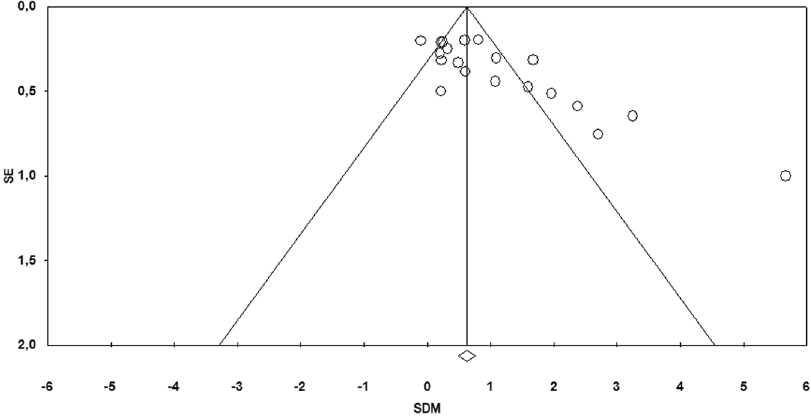
Figure 4. Funnel plot of standard error (SE) by standardised difference in means (SDM). A funnel plot obtained by plotting SE versus SDM demonstrates asymmetry to the right and therefore the presence of a potential publication